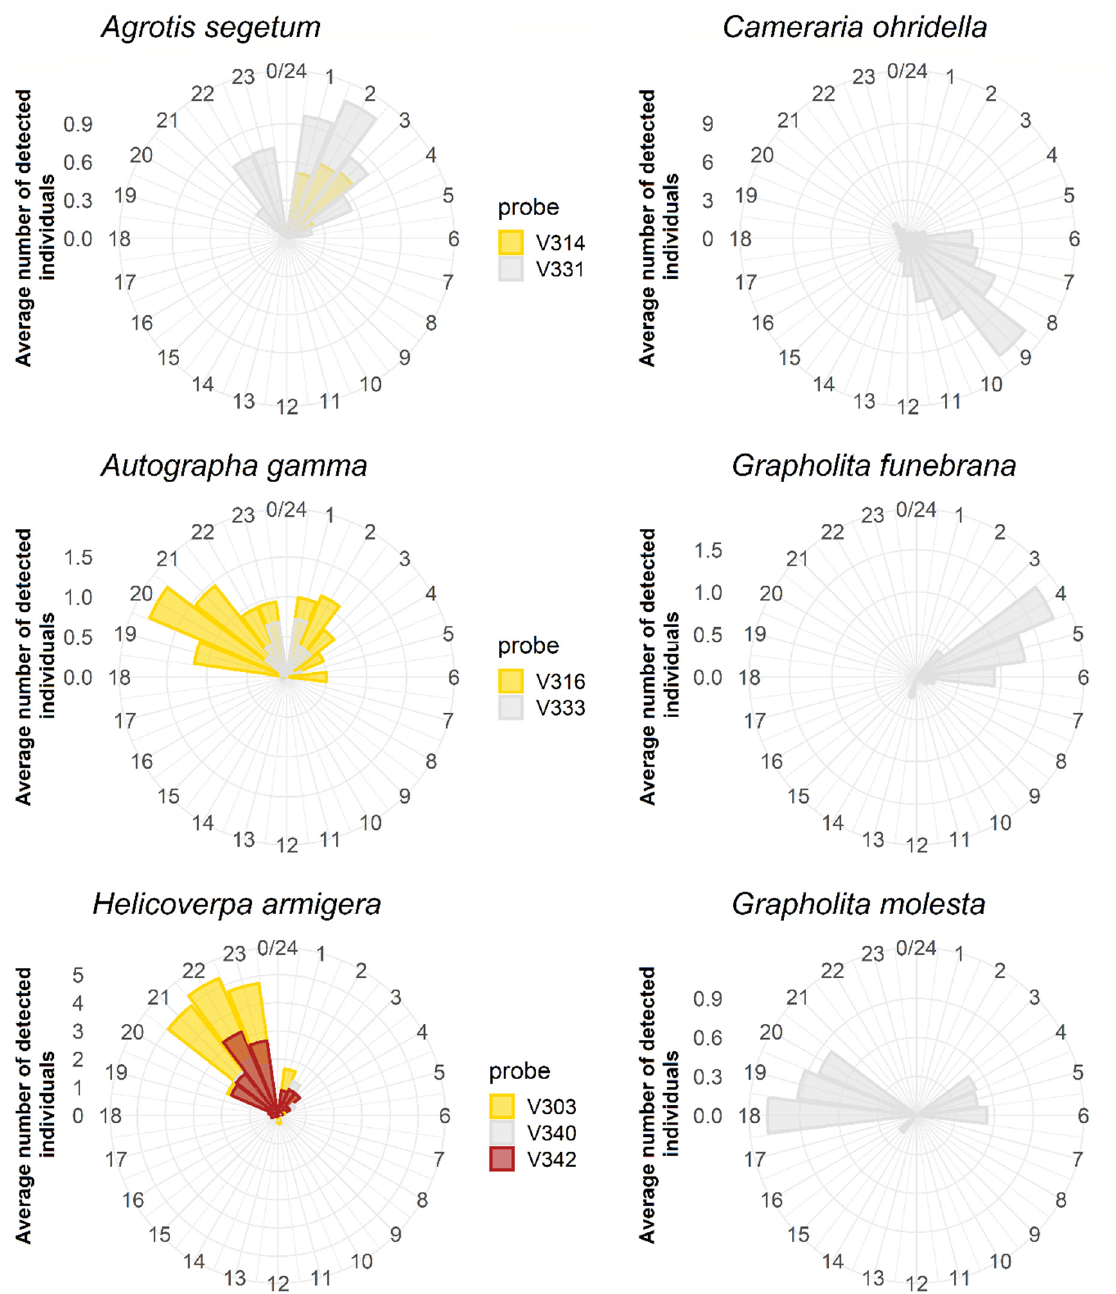
Figure 5. Daily flight activity periods of the six target species. The data were generated by the ZooLog VARL probes for at least 11 weeks from July to October 2018, depending on the flight period of the species. Di ff erent colours represent data deriving from di ff erent probes.